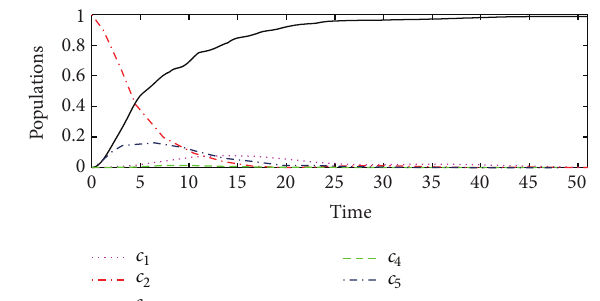
Figure 1: The population of the system state by the hybrid impulsive control based on the state